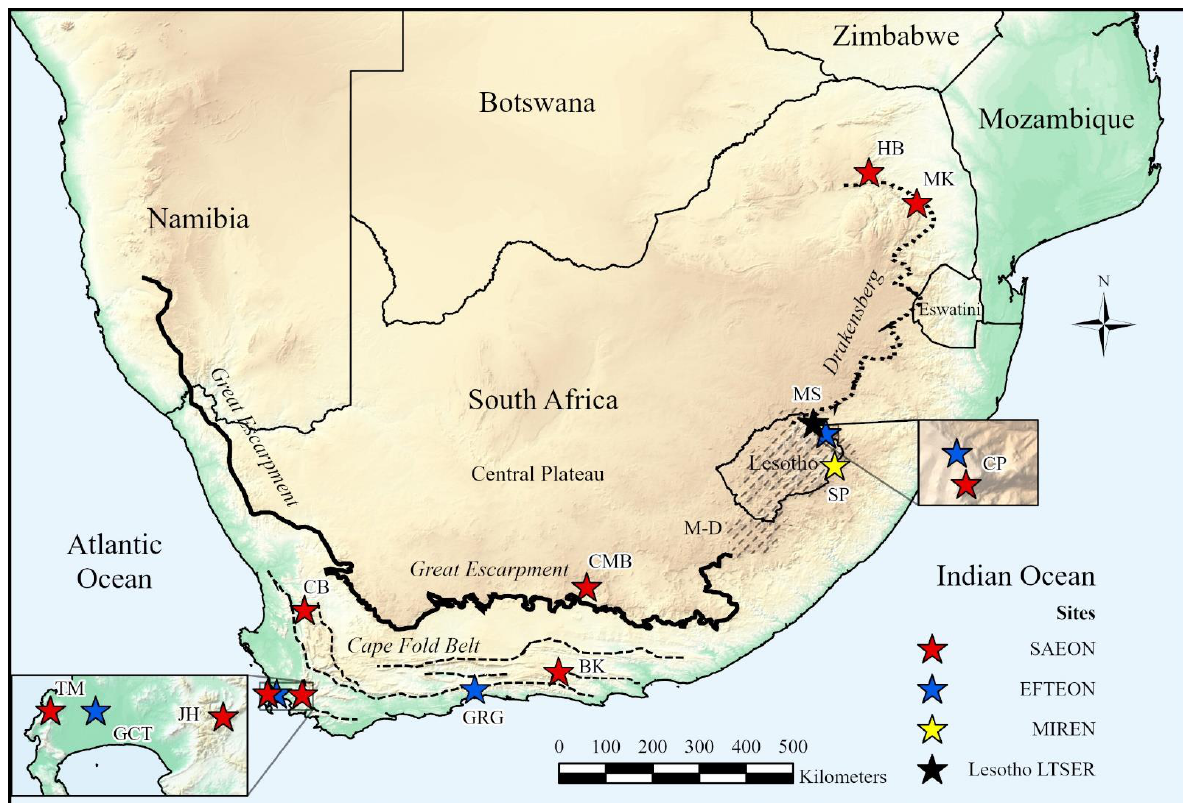
Figure 1. The location of the dominant mountain complexes and associated mountain observatories in Southern Africa. Observatories deployed by the South African Environmental Observation Network (SAEON, red stars) in the Cape Fold Belt: CB—Cederberg, Cederberg Mtns; TM—Table Mountain, Cape Peninsula Mtns; JH—Jonkershoek, Boland Mtns; BK—Baviaanskloof, Baviaans and Kouga Mtns. Great Escarpment: CMB—Compassberg, Sneeuberge; CP—Cathedral Peak, Maloti-Drakensberg; MK—Mariepskop,